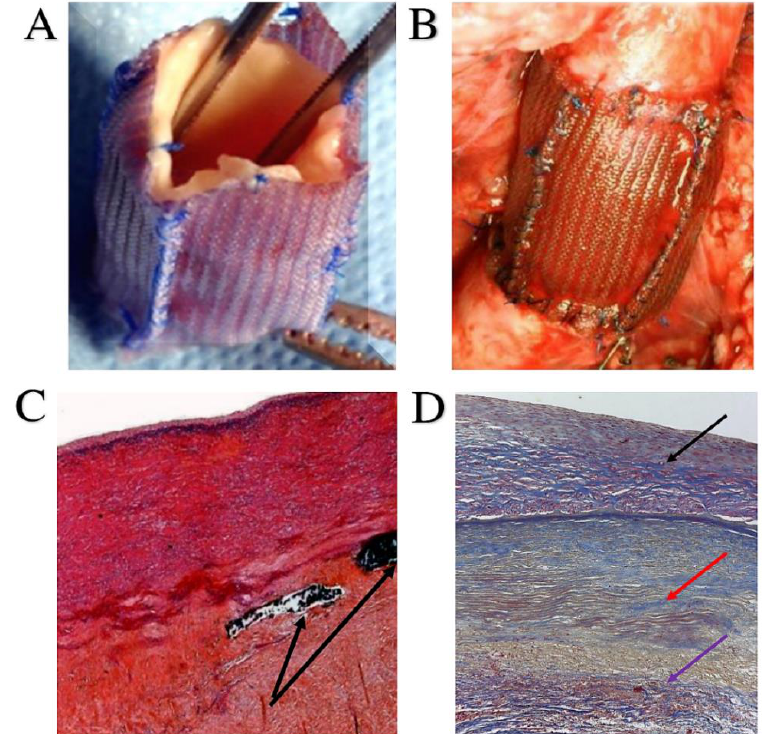
Figure 7. ( A ) Pulmonary autograft reinforced with 15 mm-wide bands of knitted PDS. ( B ) PA implanted in aortic position. ( C ) The media of pulmonary autograft is perfectly intact. Remnants of the slowly resorbable material of PDS are highlighted in the adventitia (black arrow). ( D ) The histology of PA revealed a complete resorption of the PDS mesh with no damage to the media and an increase in the regenerative connective component especially at adventitial level. This regenerative tissue was found to be constituted by elastic fibers as can be seen in the Masson’s Trichrome staining. Black arrow shows the tunica media with normal thickness and no disruption, red arrow reveals elastin fibers and violet arrow highlights no inflammatory reaction. Abbreviations: PDS, polydioxanone (Ethicon Inc. Johnson & Johnson; Bridgewater, NJ, USA); PA, pulmonary